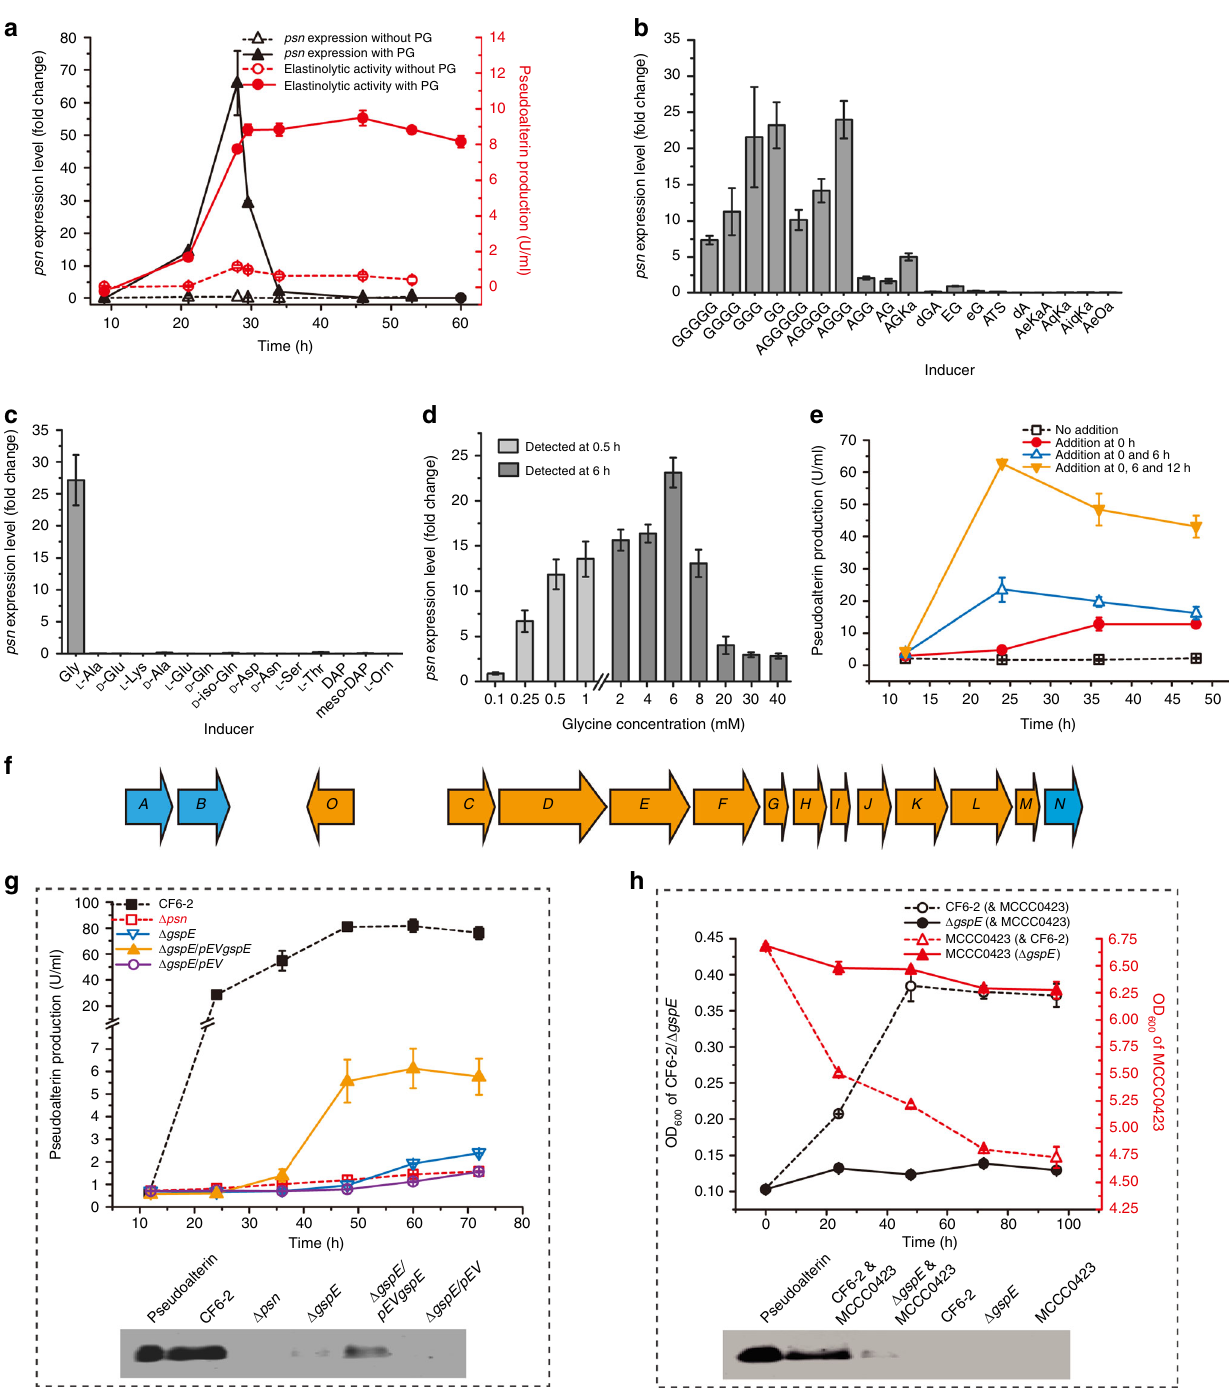
Fig. 4 Induction and secretion of pseudoalterin in strain CF6-2. a Induction of psn expression in strain CF6-2 by PG of strain MCCC0423. Control, strain CF6-2 was cultured in the medium without PG. b Inducing effects of peptides derived from PG on psn expression. O, L -Orn; iq, D -iso-Gln. c Inducing effects of amino acids from PG on psn expression. d Inducing effects of different concentrations of glycine on psn expression. e The extracellular pseudoalterin production of strain CF6-2 induced by 2 mM glycine added at 0, 6, and/or 12 h. Control, strain CF6-2 was cultured in the medium without glycine. The pseudoalterin production was represented by the extracellular elastinolytic activity. f Genetic organization of the T2SS cluster of strain CF6-2. Each gene is represented by an arrow. The “ core ” genes in the cluster are marked in orange and the others ( gspA , B , and N ) in blue. g Pseudoalterin production of strain CF6-2 and its mutants cultured in a fermentation medium. The upper shows pseudoalterin production represented by extracellular elastinolytic activity. The lower shows pseudoalterin production detected by western blot. h Non-contact co-culture of strain Δ gspE and strain MCCC0423. The upper panel shows the growth of the strains. The lower panel shows pseudoalterin production detected by western blot. The graphs show data from triplicate experiments (mean ± SD). Source data are provided as a Source Data fi